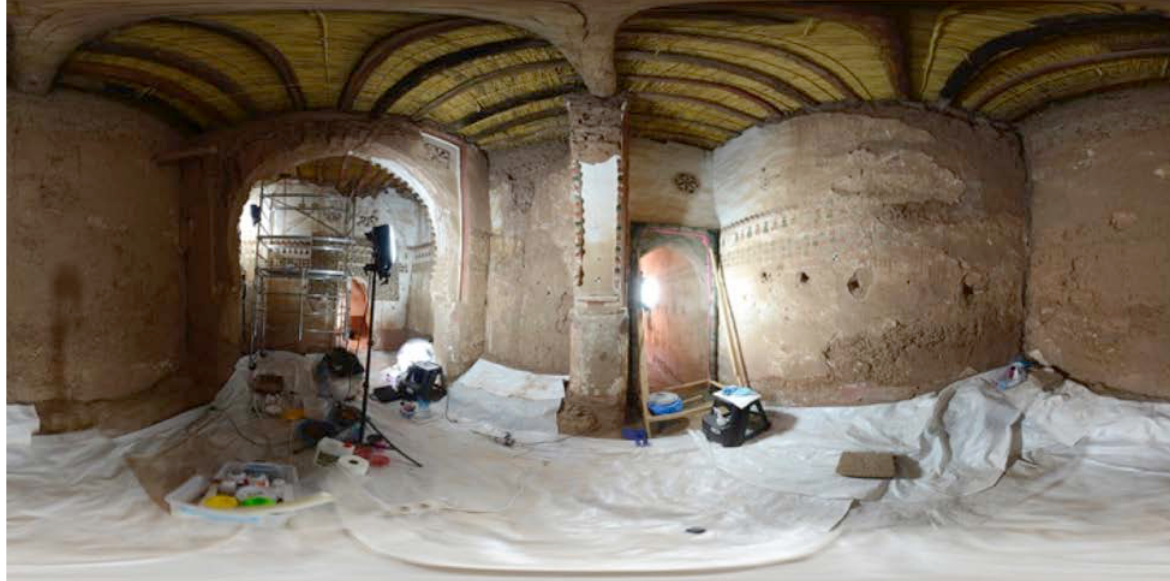
Figure 1: Panoramic view of one of the decorated rooms at the Caid Residence at Kasbah of